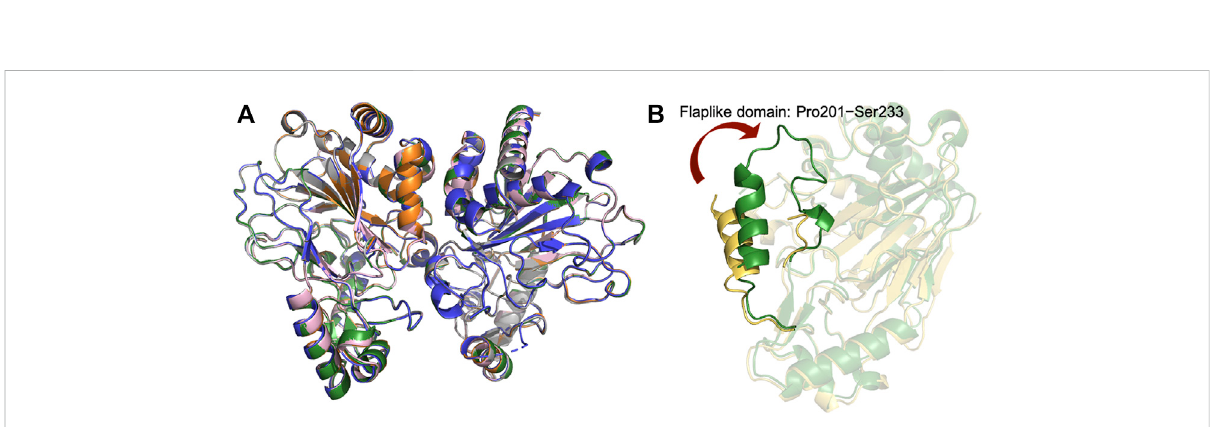
FIGURE 4 CrystalstructuresofCmnCinfreeformandthecomplexstructures. (A) SuperpositionofthestructuresofCmnC apo (green),CmnC L − Arg (orange), CmnC L -hArg (grey), CmnC α -kg (blue), and CmnC L − Arg, α -kg (pink). (B) Superposition of two polypeptide chains from the CmnC apo dimer. The two polypeptide chains are colored green and